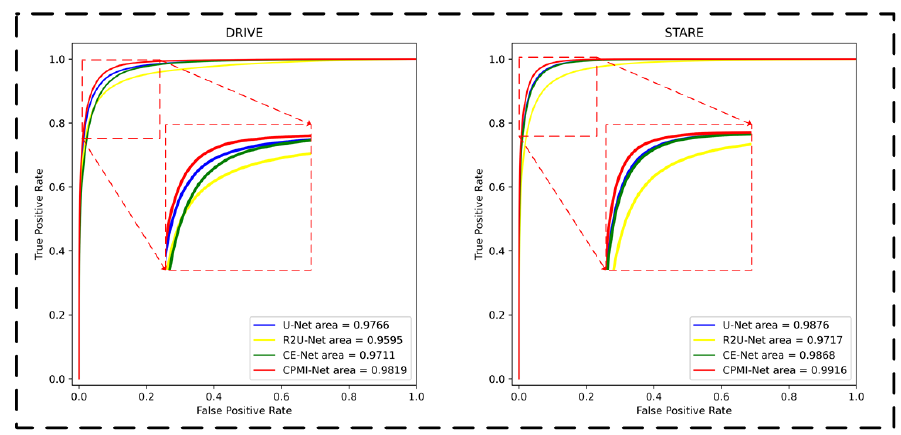
Figure 11. ROC curves of our model and some advanced